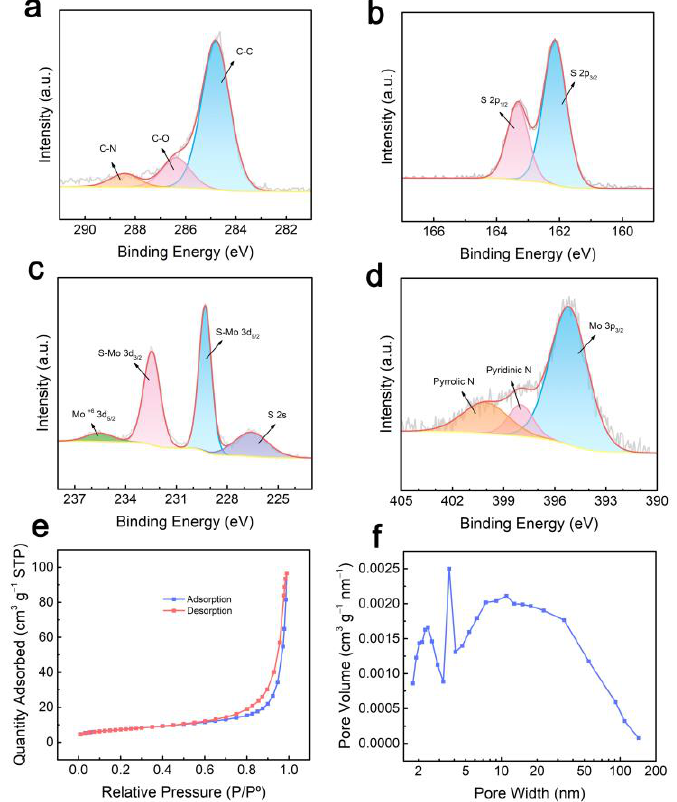
Figure 3. Characterization of samples. ( a – d ) High-resolution C 1s, S 2p, Mo 3d, and N 1s XPS spectra of C-MoS 2 -1. ( e , f ) N 2 adsorption–desorption isotherm and BJH pore-size distribution curve of C-MoS 2 -1.